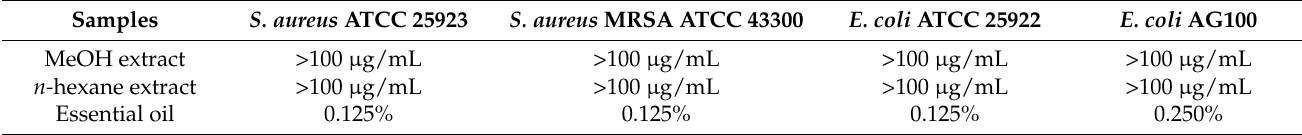
Table 3. MIC values of the extracts and essential oil of O. majorana .